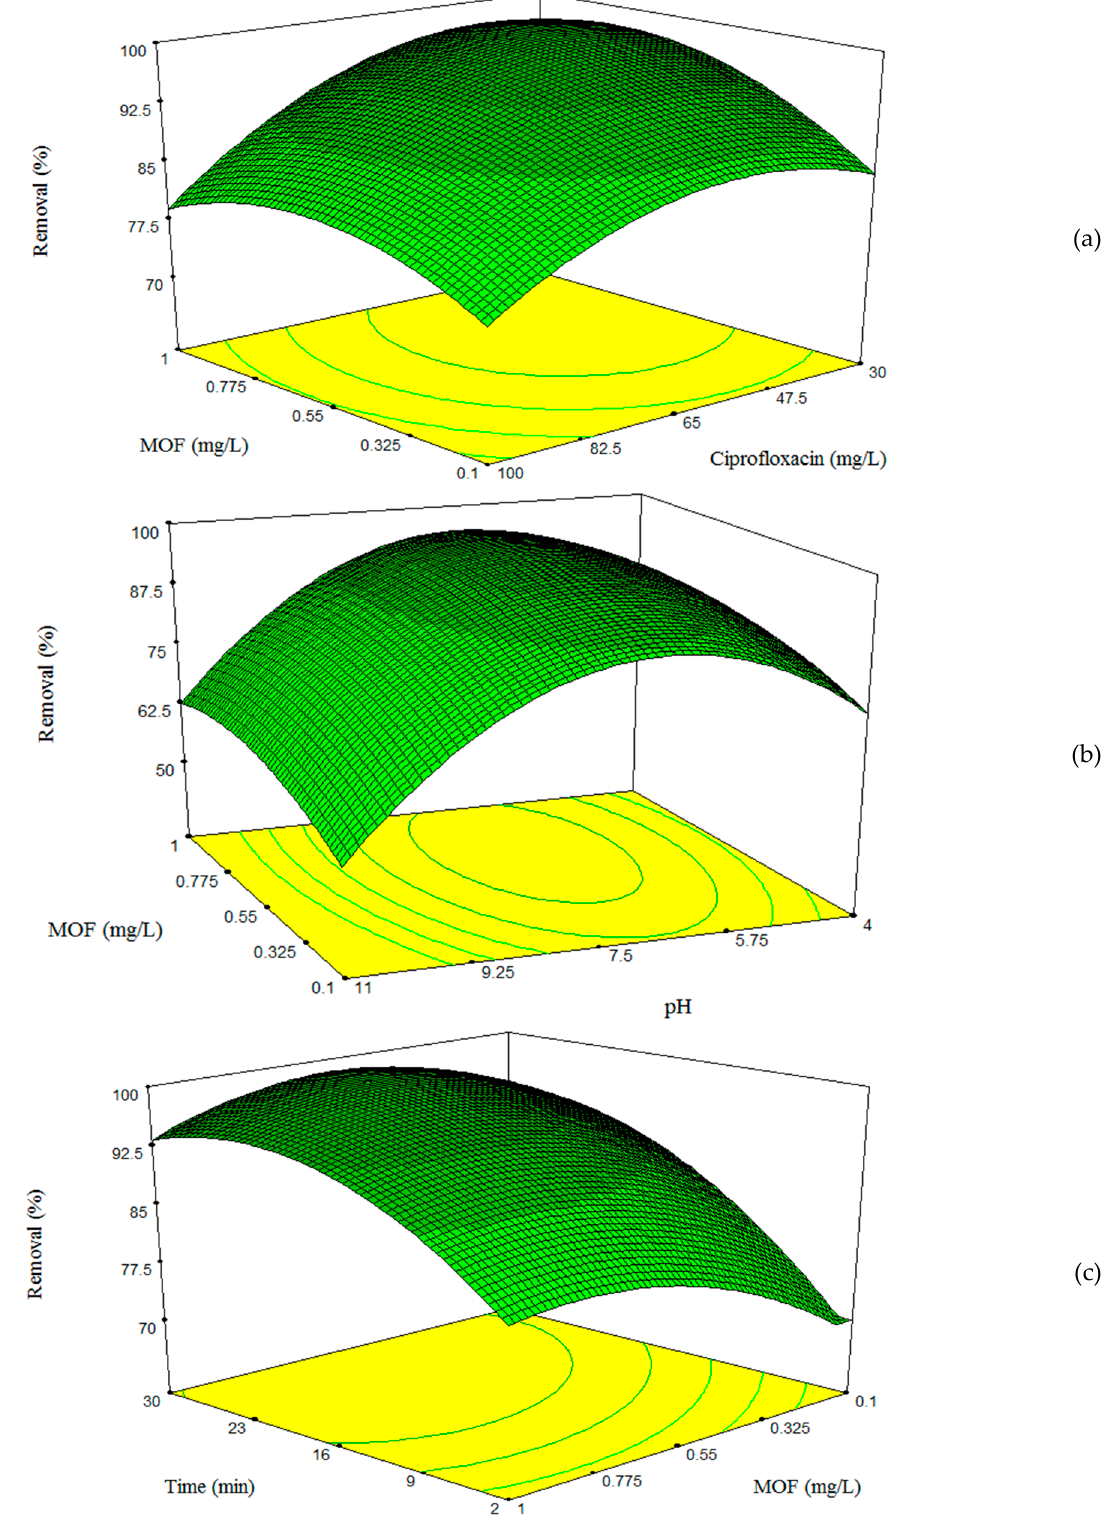
Figure 4. Effect of sorption variables on CIP removal: ( a ) the effect of MOF and CIP concentration, ( b ) Figure 4. E ff ect of sorption variables on CIP removal: ( a ) the e ff ect of MOF and CIP concentration, ( b ) MOF and pH, ( c ) MOF and agitation time. MOF and pH, ( c ) MOF and agitation